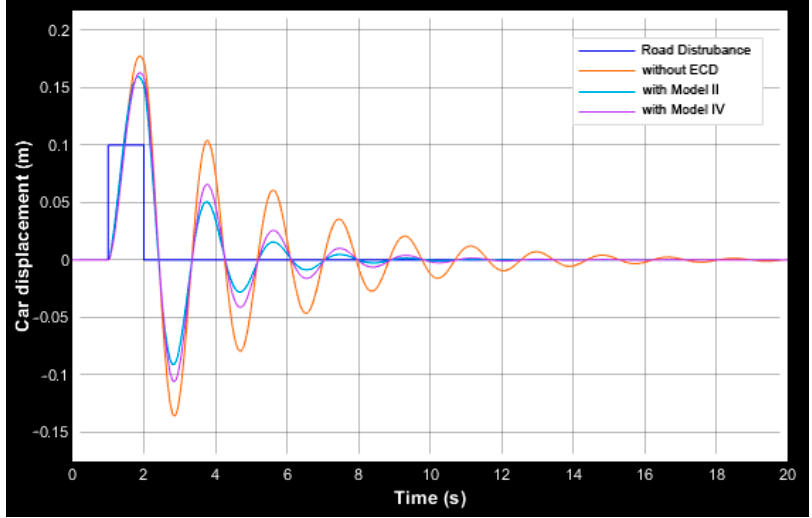
Figure 11. Comparison between the suspension displacement response during road disturbance, between Models II and IV.